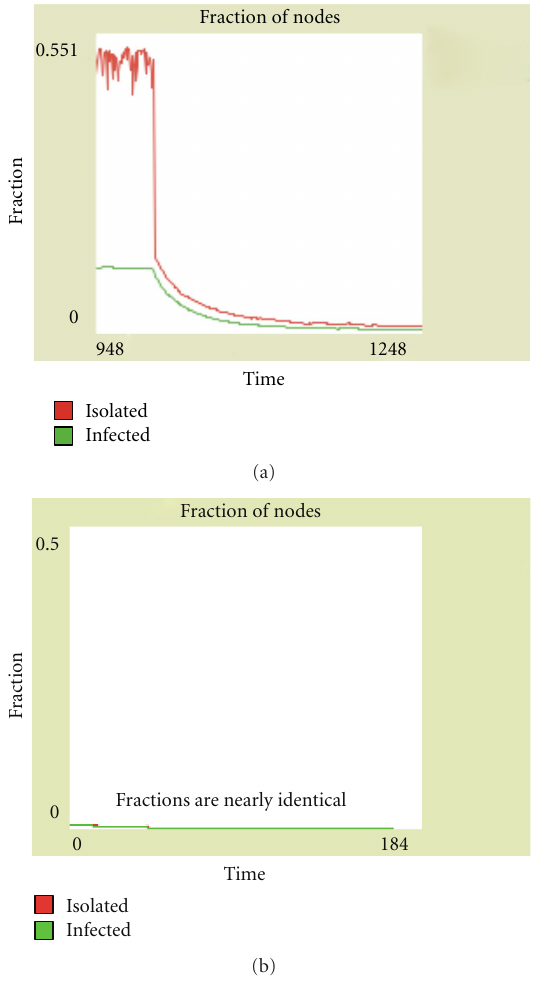
Figure 5: Fractions of isolated and infected nodes caused by multiple simultaneous virus outbreaks on DH network. (a) The largest 216 hubs are immunized at time step one thousand. (b) The hubs have been correctly identified and immunized before the virus outbreaks.